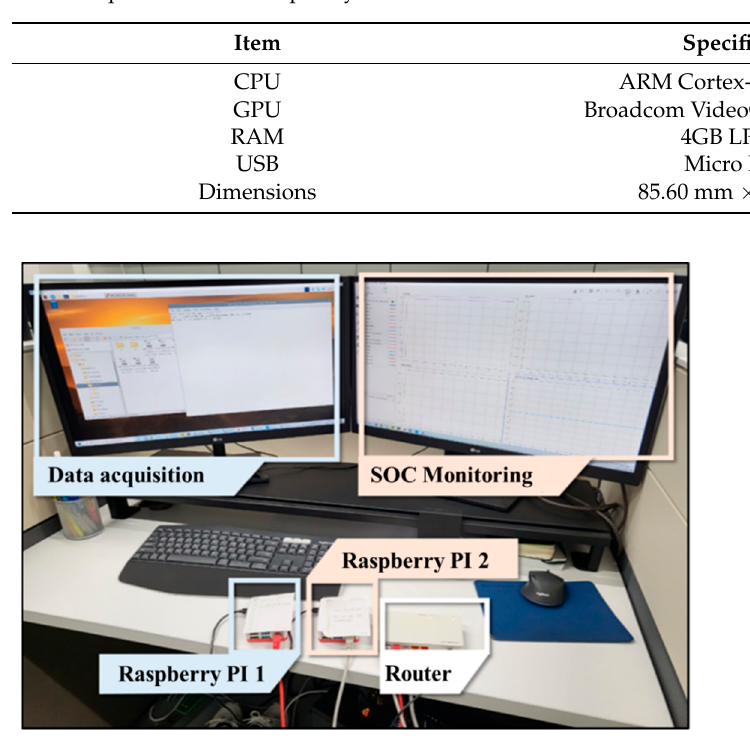
Figure 7. Experimental setup of Raspberry Pi.